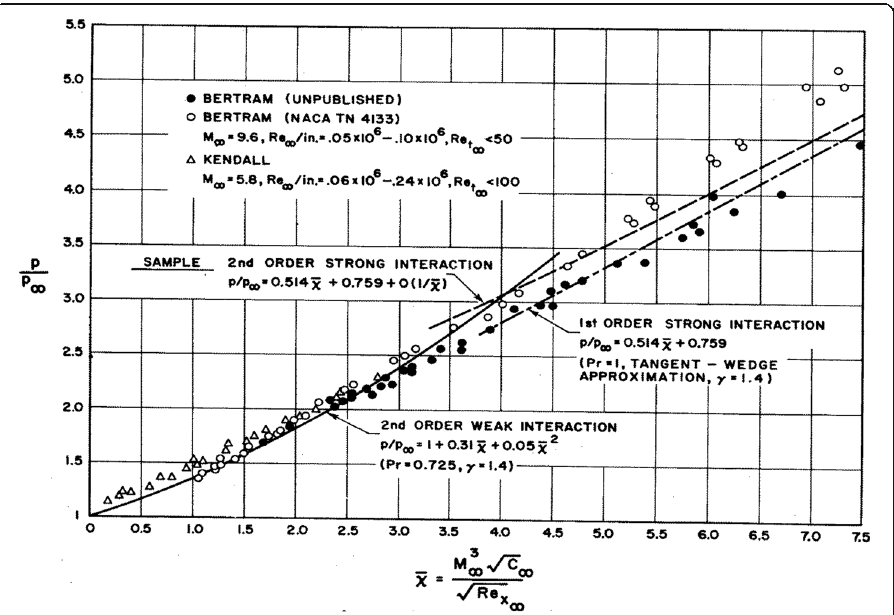
Fig. 2 Validate Mach-Wave interaction at sharp leading